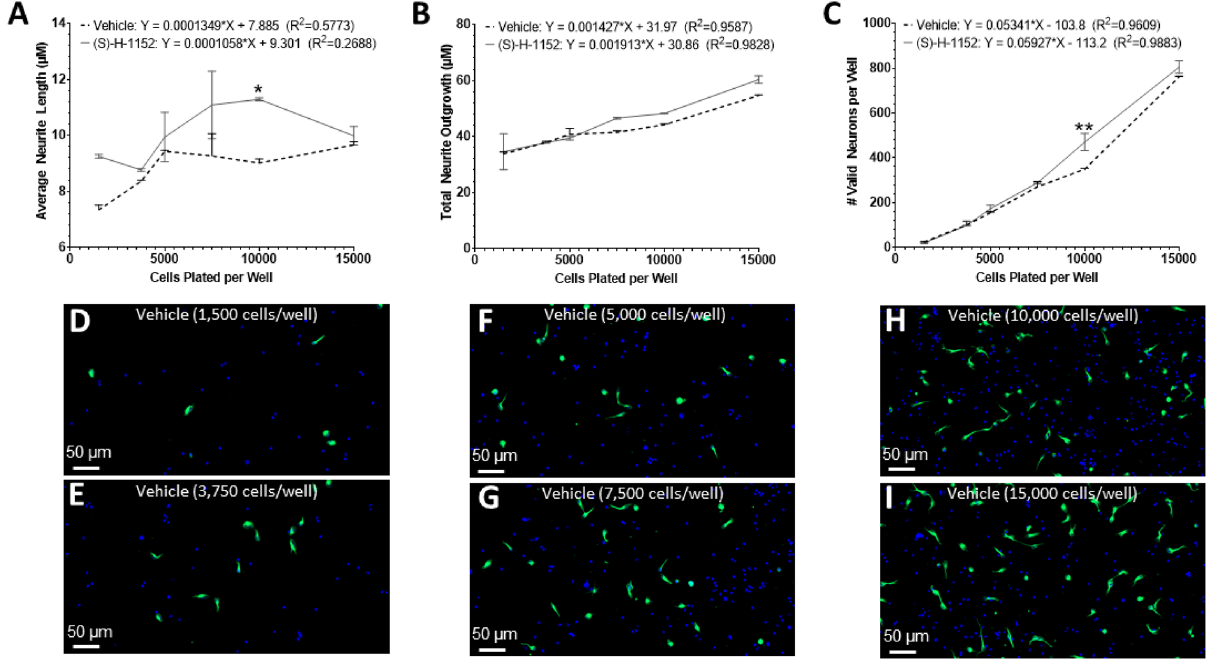
Figure 3. The effects of cell plating density. Linear trends of the ( A ) average neurite length, ( B ) total neurite outgrowth, and ( C ) number of valid neurons of Vehicle and (S)-H-1152 treated primary cortical neurons isolated from young adult male mice cultured for 2DIV. The X-axis denotes the number of cells plated in each well. Representative × 20 magnification images of primary cortical neurons from young adult male mice treated with Vehicle for 2DIV and plated at ( D ) 1500 cells/well, ( E ) 3750 cells/well, ( F ) 5000 cells/well, ( G ) 7500 cells/ well, ( H ) 10,000 cells/well, and ( I ) 15,000 cells/well; stained with TUBB3 (Green) and DAPI (Blue). Two-way ANOVA with Šídák’s multiple comparisons test was used to compare the means of neurons with different treatments for each respective plating density denoted by *(P < 0.05), **(P < 0.01), ***(P < 0.001), ****(P < 0.0001). Simple liner regression conducted to determine goodness of fit and if the slope differs significantly from 0. Linear regression t-test was used to compare the slope of the regression lines. 2 wells per condition (n = 2). Graphs show mean and SEM. Scale Bar = 50